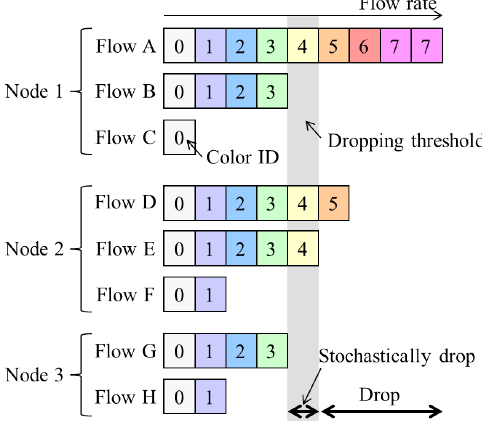
Figure 2. Concept for N Rate N + 1 Color Marking (NRN + 1CM); colors are assigned to frames according to the flow input rate. Frames are selectively discarded on the basis of a dropping threshold and the frame color.